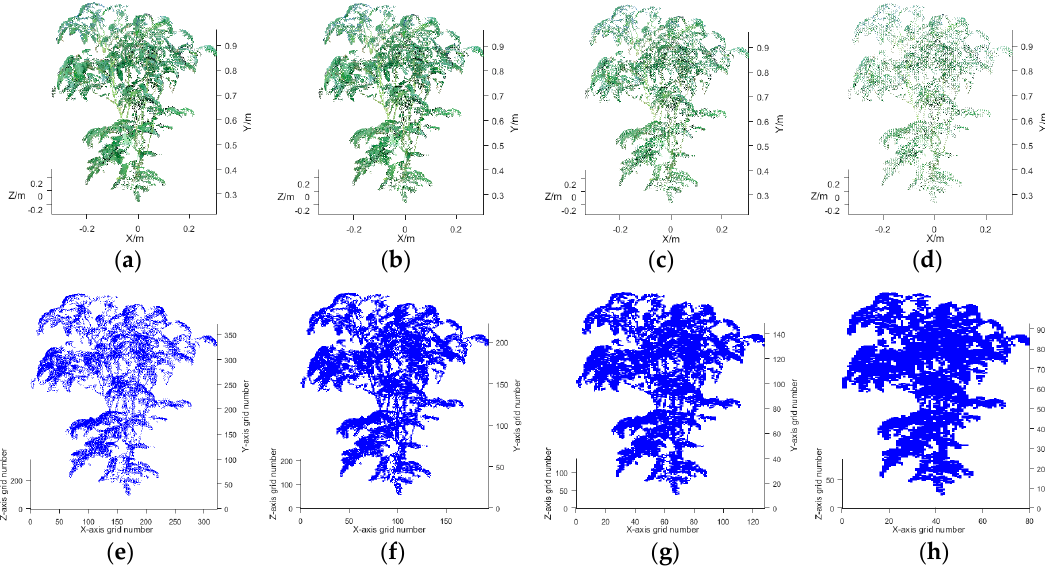
Figure 9. Calculation of the canopy volume of a greenhouse tomato plant: ( a ) Box filter: 2 mm; ( b ) Box filter: 3.3 mm; ( c ) Box filter: 5 mm; ( d ) Box filter: 8 mm; ( e ) Voxel: 2 × 2 × 2 mm 3 ; ( f ) Voxel: 3.3 × 3.3 × 3.3 mm 3 ; ( g ) Voxel: 5 × 5 × 5 mm 3 ; ( h ) Voxel: 8 × 8 × 8 mm 3